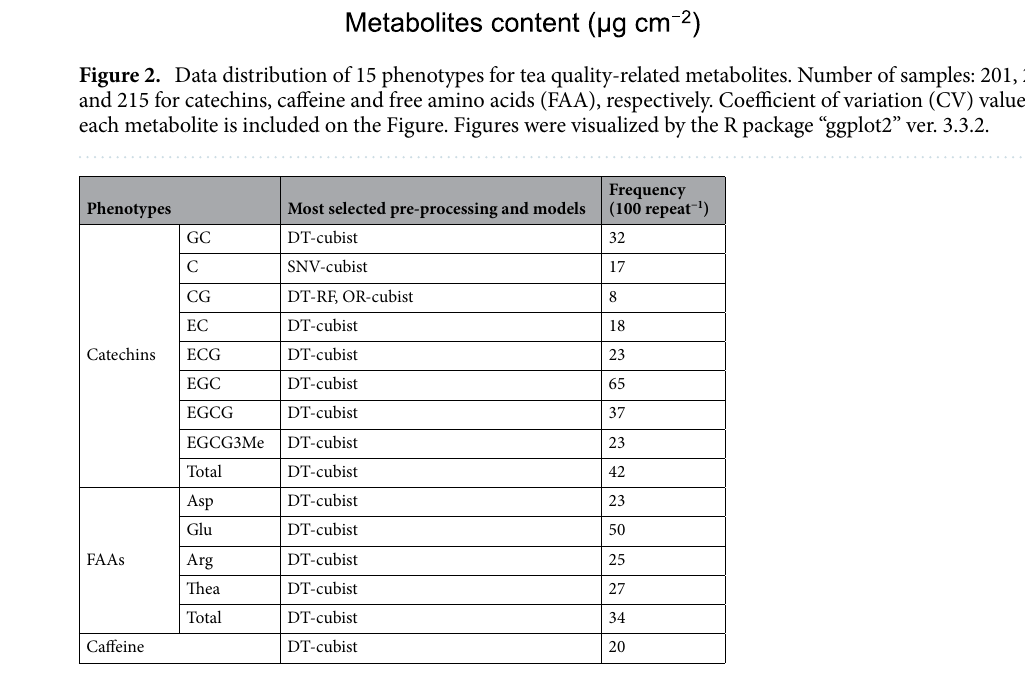
Table 1. Best combination of pre-processing and machine learning algorithms after 100 repetitions. Combination of pre-processing and machine learning algorithms were evaluated based on RPD values.